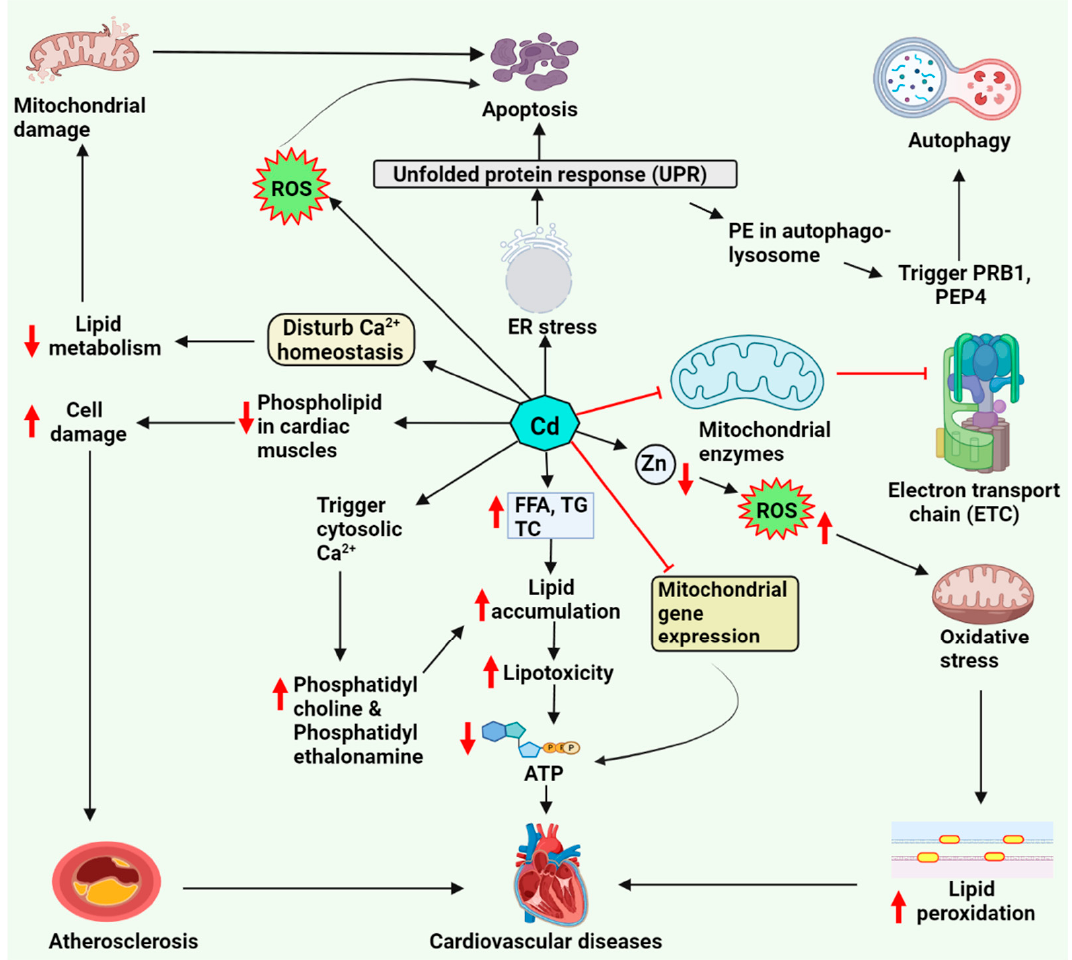
Figure 1. Cadmium-induced lipid deregulation and cardiotoxicity. Cadmium generates ROS, resulting in oxidative stress, which leads to increased lipid peroxidation; it also causes endoplasmic reticulum stress and disturbs calcium signaling. These basic mechanisms alter lipid metabolism and cause mitochondrial damage, leading to cardiac cell apoptosis and cardiovascular damage. Abbreviations: ATP, adenosine triphosphate; FFA, free fatty acid; PE, phosphatidylethanolamine; PEP4, pepstatin A; PRB1, proteinase B1; ROS, reactive oxygen species; TC, total cholesterol; TG, triglyceride.